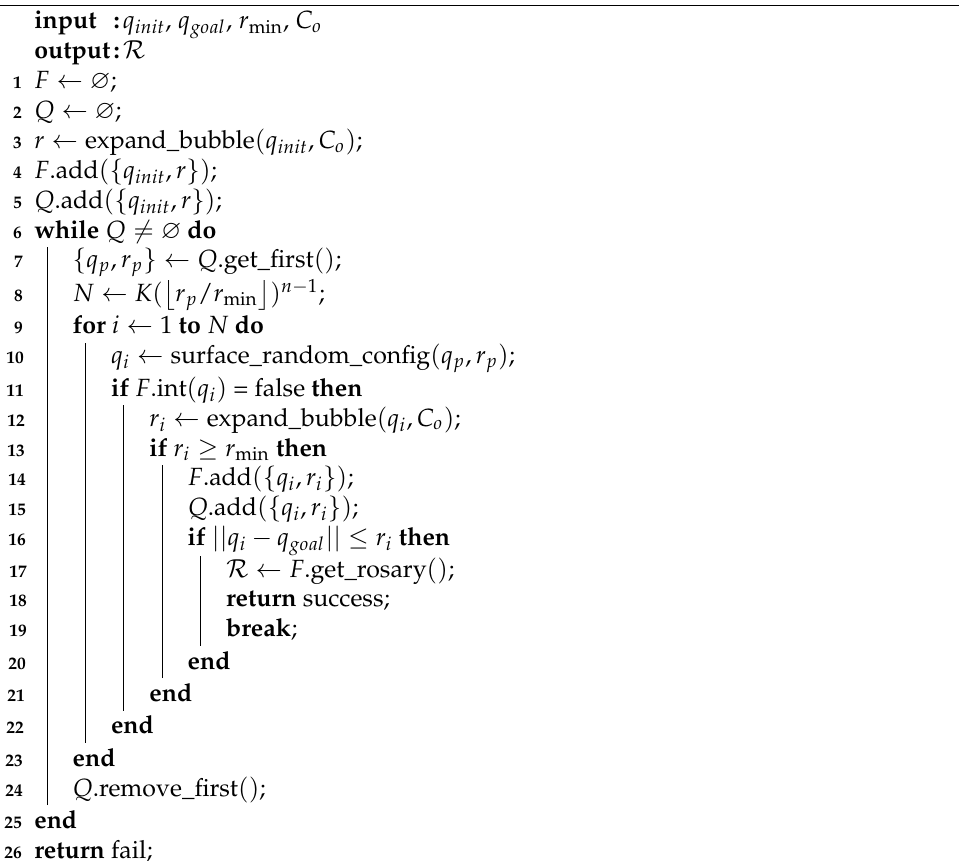
Algorithm 1: Probabilistic Foam